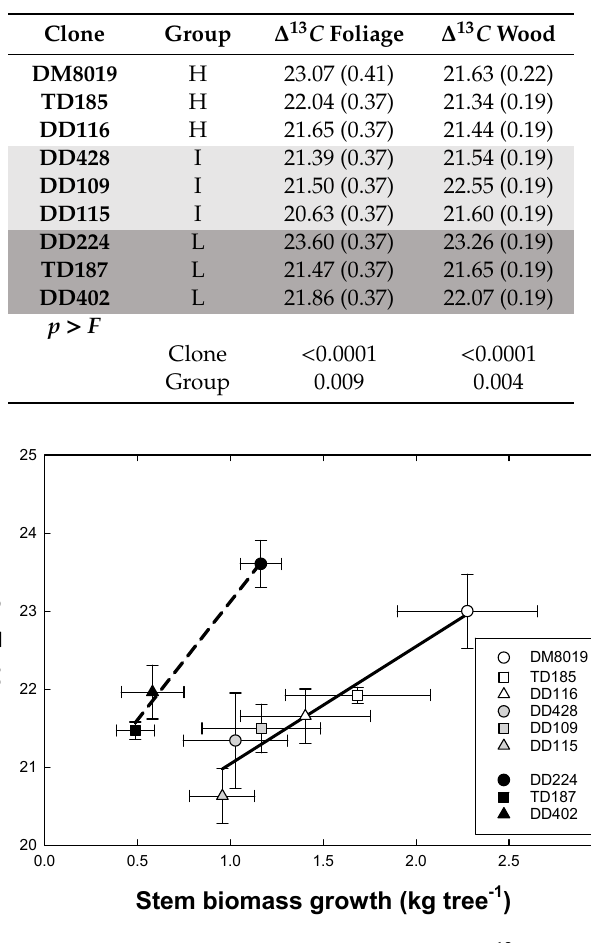
Figure 9. Relationship between leaf carbon isotope discrimination ( Δ 13 C) and water use efficiency of production (WUEp) and stem biomass growth in P. deltoides (DD), P. trichocarpa × deltoides (TD), and P. deltoides × maximowiczii (DM) clones. Open, light shaded, and dark shaded symbols represent high (Group H), intermediate (Group I), and low (Group L) productivity genotypes, respectively. Each point is the mean of three or four or trees.